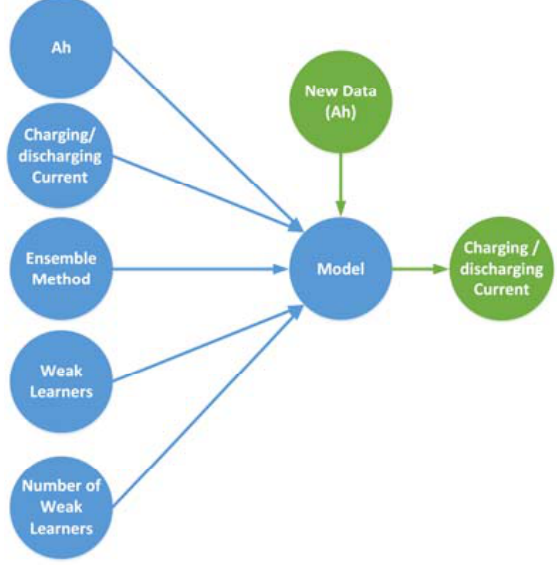
Figure 9. Ensemble Learning Model.